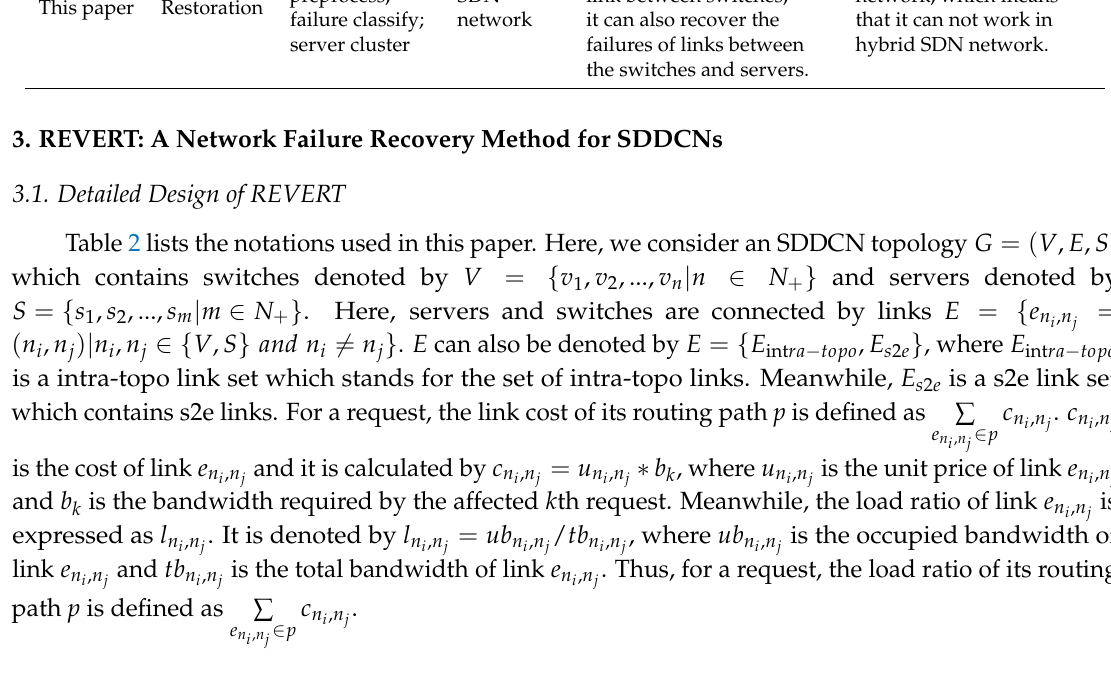
Table 2. Notations used in the